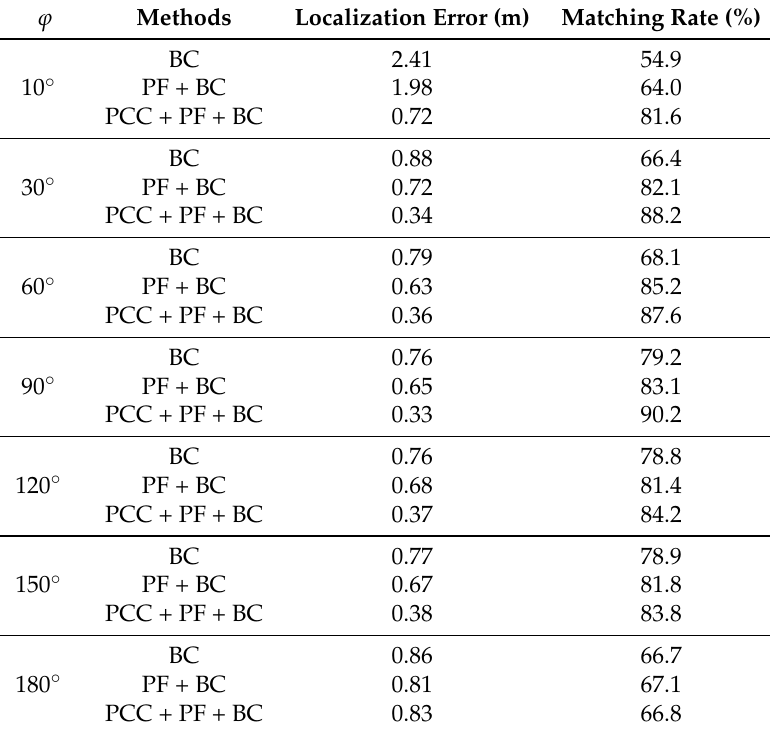
Table 4. The influence of phase shift threshold ϕ on experimental results. ϕ